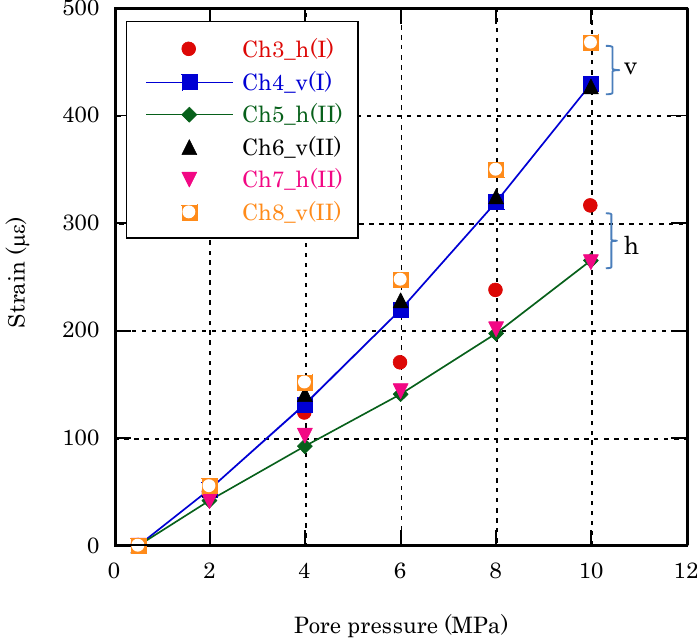
Figure 12. Tako core strain gauge readings at stage 2 showing the vertical strains being notably higher than the hoop strains. I—coarse-grain region; II—fine-grain region.